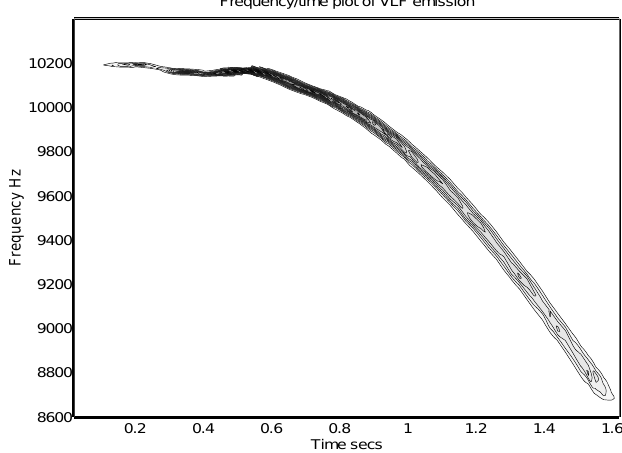
Surface plot of dW; z= −42.74